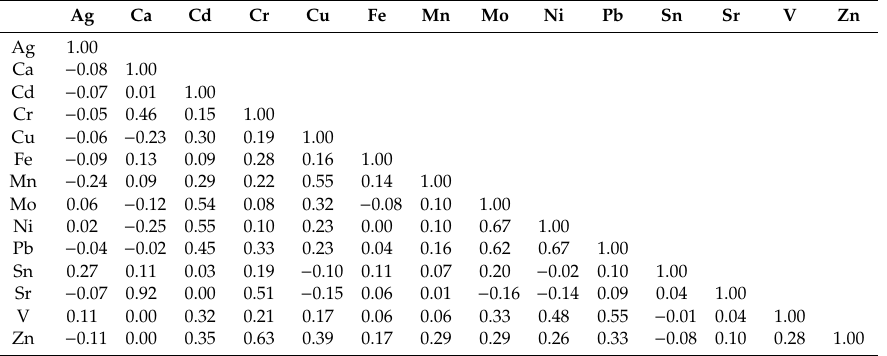
Table 7. Pearson’s correlation coe ffi cients for metals found in the placenta ( p <